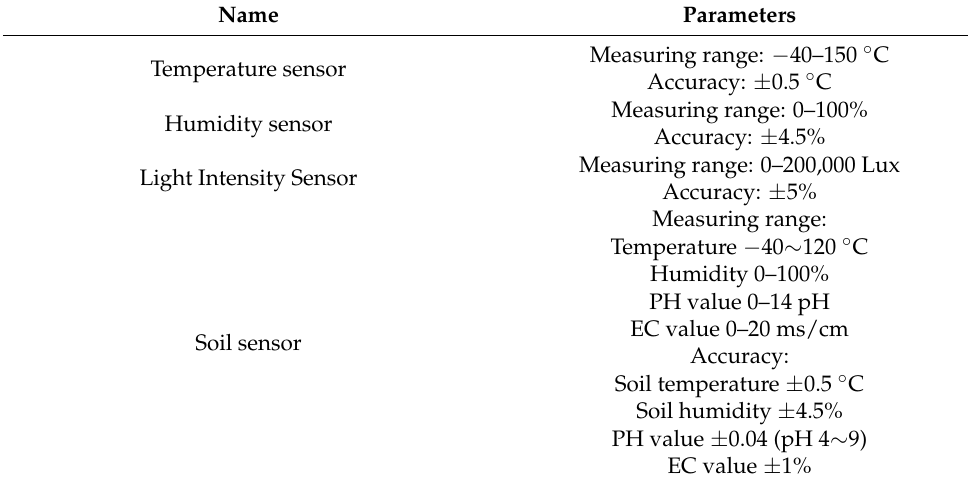
Table 1. List of sensors used by the